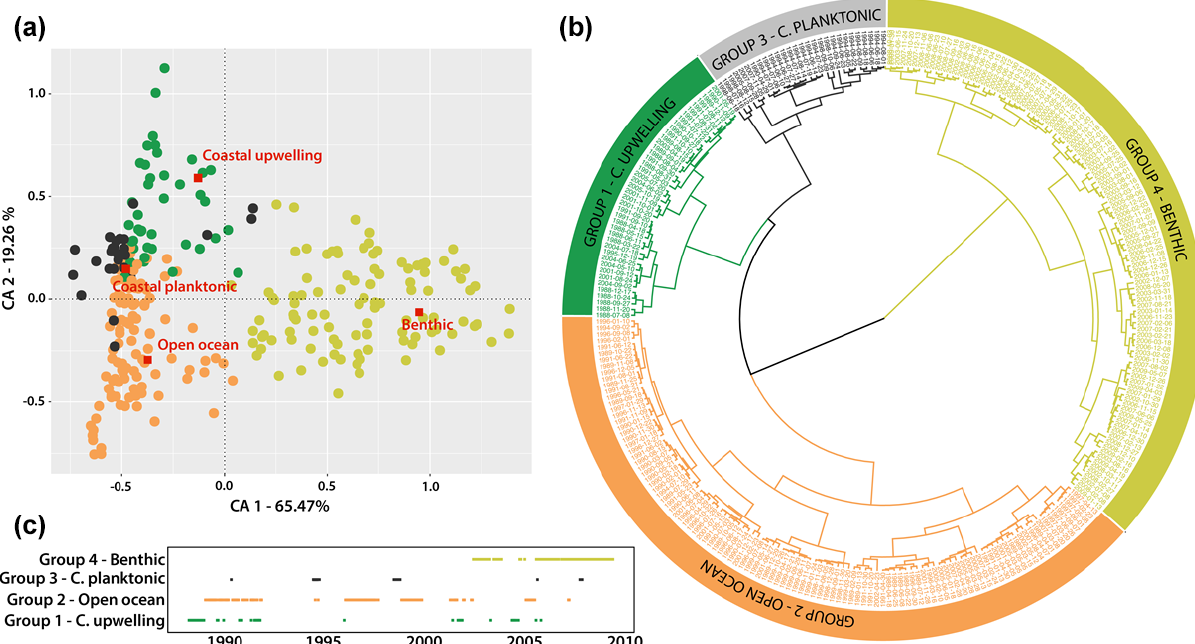
Figure 3. (a) Correspondence analysis (CA) of diatom groups found at the CBmeso site between March 1988 and June 2009, coupled with (b) a hierarchical clustering analysis of samples’ score resulting from CA (see Sect. 2.3). Note that in (a) the red squares for each group represent the centroid of dates and their placement within the corresponding group. The corresponding group’s name is written in red. (c) The time series of the four diatom groups identified by both multivariate analyses (CA and clustering) is also represented. Colors used for identifying each diatom group are the same as in Fig. 2b. Euclidean distance and Ward’s aggregation link were used to perform the hierarchical dendrogram. For the species-specific composition of each group, see Sect. 4.2. and Table 2. For interpretation of the references to color in this figure legend, the reader is referred to the web version of this